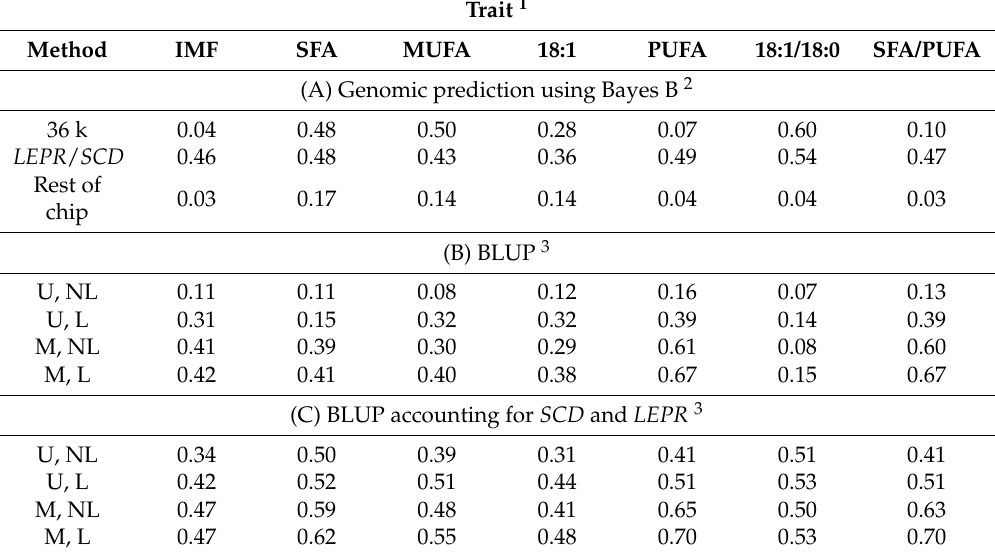
Table 2. Correlations between predicted breeding values and adjusted phenotypes in a set of 70 pigs born in 2009 using different genomic pedigree and phenotypic data collected since 2002 (adapted from [6,20]). Trait